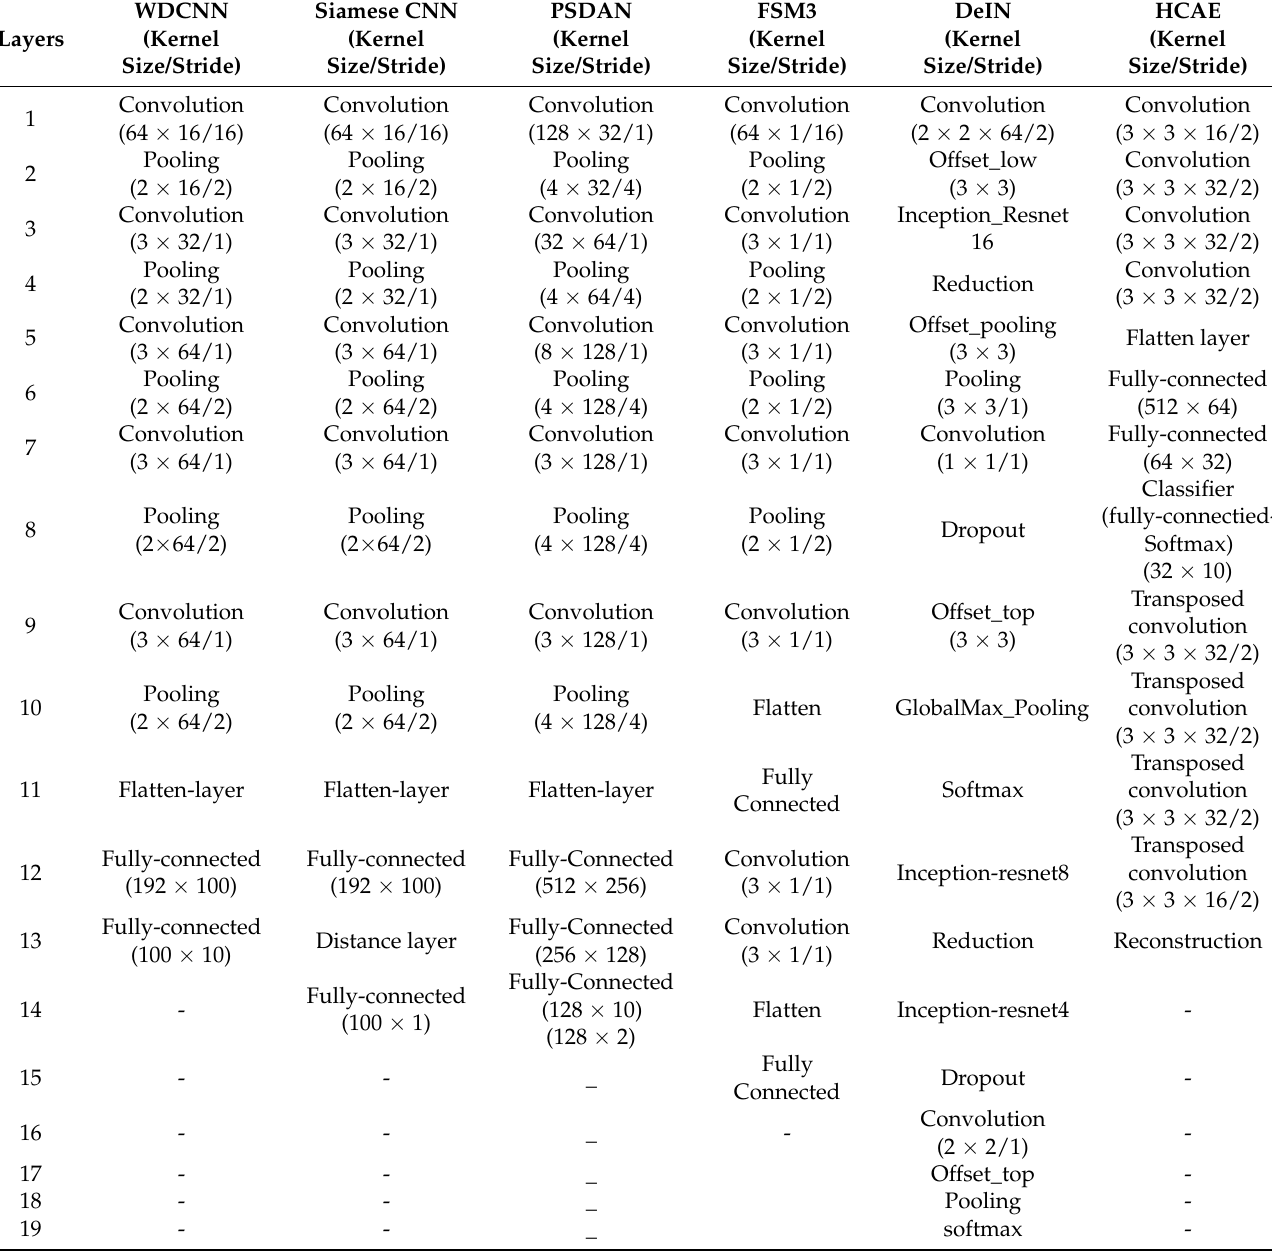
Table 4. Details of the comparison